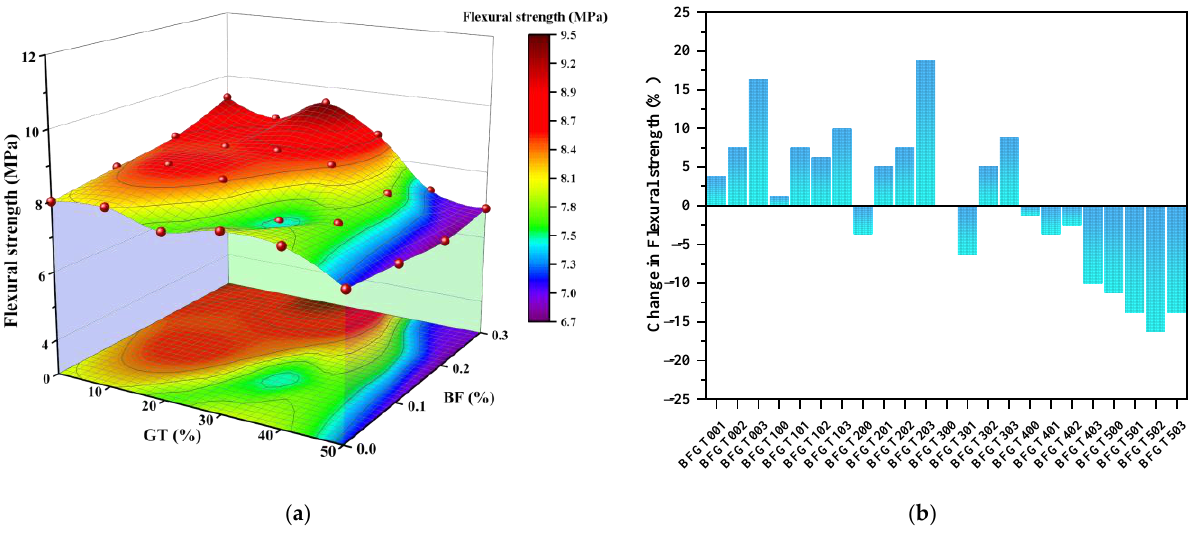
Figure 7. Test results of 28-day age BFR-GTCM flexural strength: ( a ) flexural strength at 28 days of age; ( b ) change in flexural strength at 28 days of age (based on BFGT000).